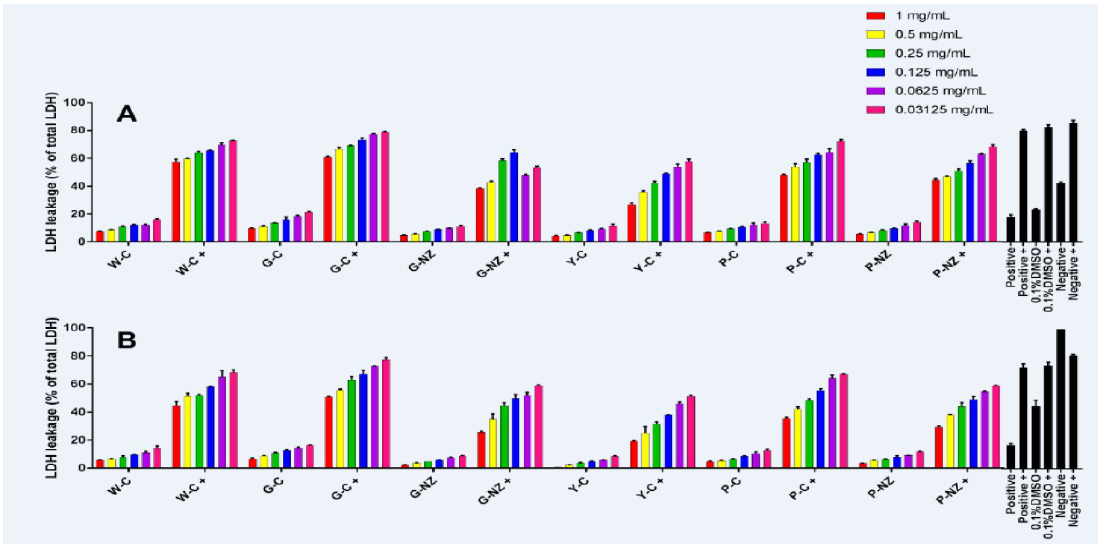
Figure 4. The capacity of different cultivars AR investigated at the different concentrations in protecting HepG2 and L 929 cells from H 2 O 2 exposure in the LDH assay. Data presented as mean ± SEM from three replicates of the cell culture experiments ( n = 3) from each sample. Positive control: cell culture medium; Negative control: 1% SDS medium; 0.1% DMSO control: 0.1% DMSO + cell culture medium. Positive control+: cell culture medium + H 2 O 2 (500 mM); Negative control+: %SDS +H 2 O 2 (500 mM); 0.1% DMSO control+: 0.1% DMSO+ cell culture medium+H 2 O 2 (500 mM).